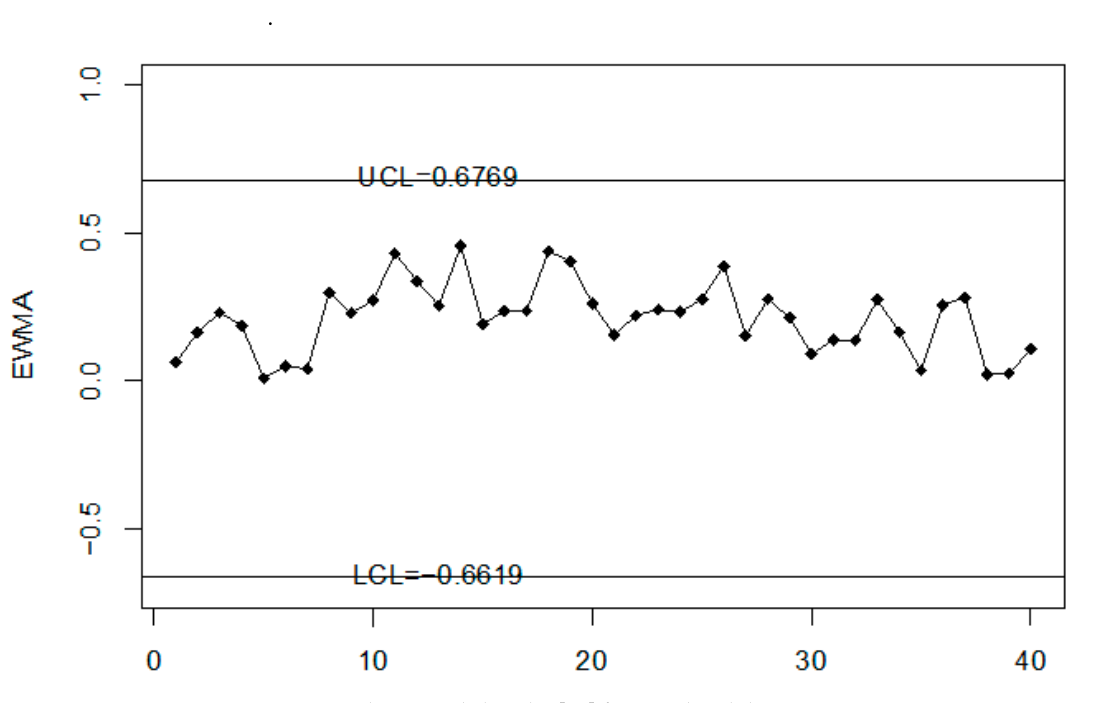
Figure 3. The control chart by [39] for simulated data set.